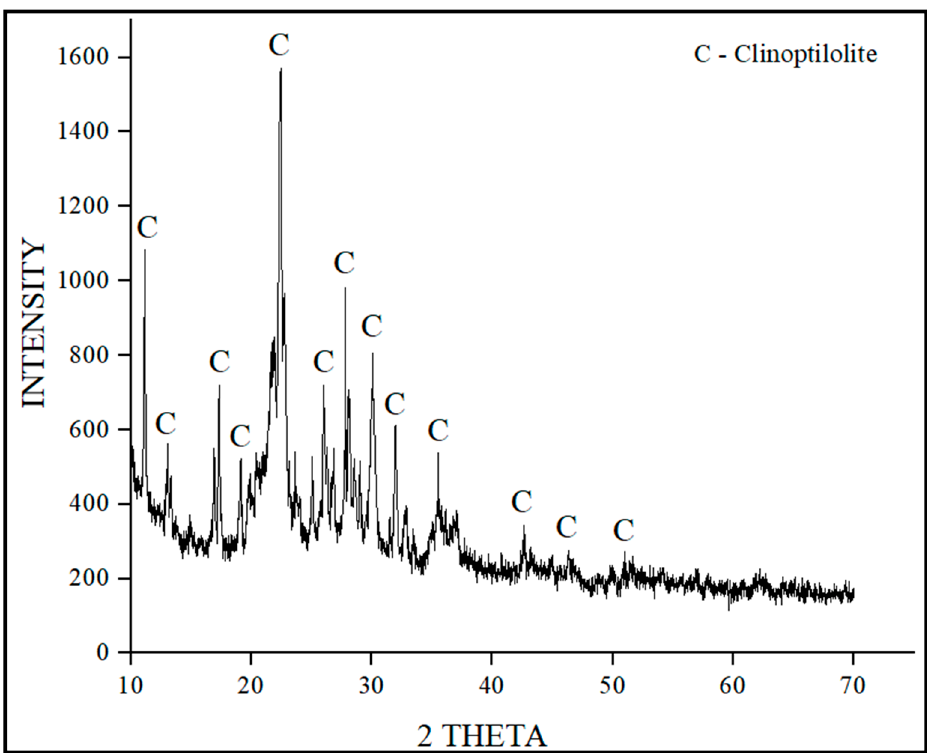
Figure 1. X-ray diffraction pattern of the natural zeolite (clinoptilolite) material. Figure 1. X-ray di ff raction pattern of the natural zeolite (clinoptilolite)